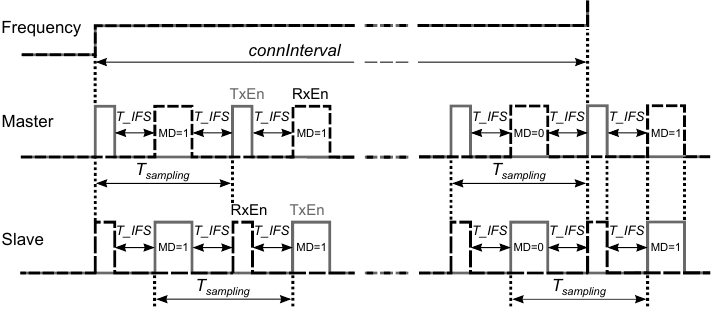
Figure 12. Transmission of data packets, which are equally spaced in time with period T sampling < 7.5 ms.